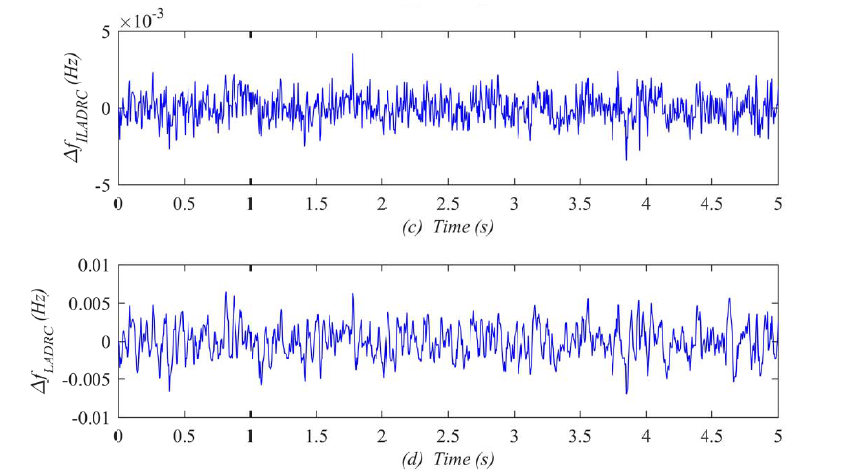
Figure 18. Transient response of system frequency deviation under stochastic load demand. ( a ) Frequency deviation with PI controller; ( b ) Frequency deviation with Fuzzy-PI controller; ( c ) Frequency deviation with ILADRC controller; ( d ) Frequency deviation with LADRC controller.